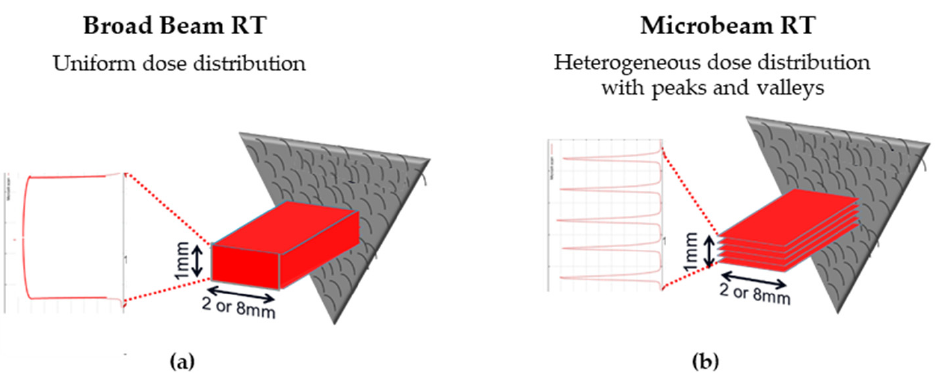
Figure 1. Synchrotron can generate both broad beams and microbeams. ( a ) Broad beam synchrotron RT is a type of conventional RT which uses spatially uniform dose distribution. ( b ) MRT has a heterogeneous dose distribution with ablative peak and low valley doses. Typical beam dimensions used in the AS experiments are described below.